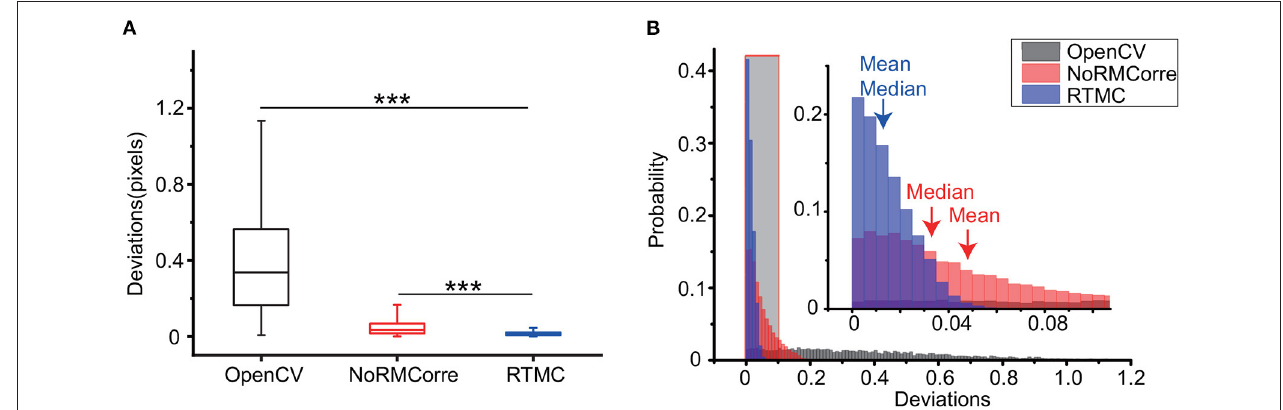
FIGURE 3 | Precision comparison of the OpenCV template matching, rigid NoRMCorre and RTMC algorithms applied on a simulated video with 5,000 frames. (A) : Box plot of the deviations of the above 3 methods (RTMC vs. OpenCV, *** p < 0.001; RTMC vs. NoRMCorre, *** p < 0.001, Wilcoxon test). (B) : Histogram of the deviations. The shadowed area indicates an enlarged range from 0 to 0.1